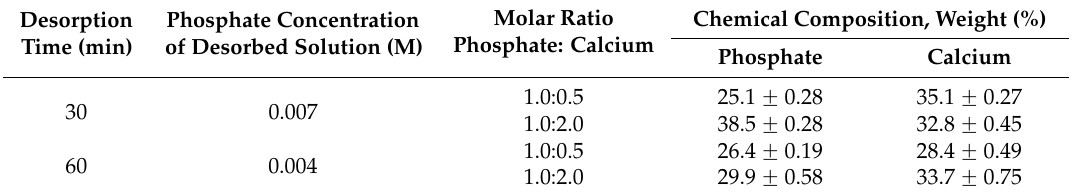
Table 3. Chemical composition of the recovered hydroxyapatite precipitate (mean ˘ standard